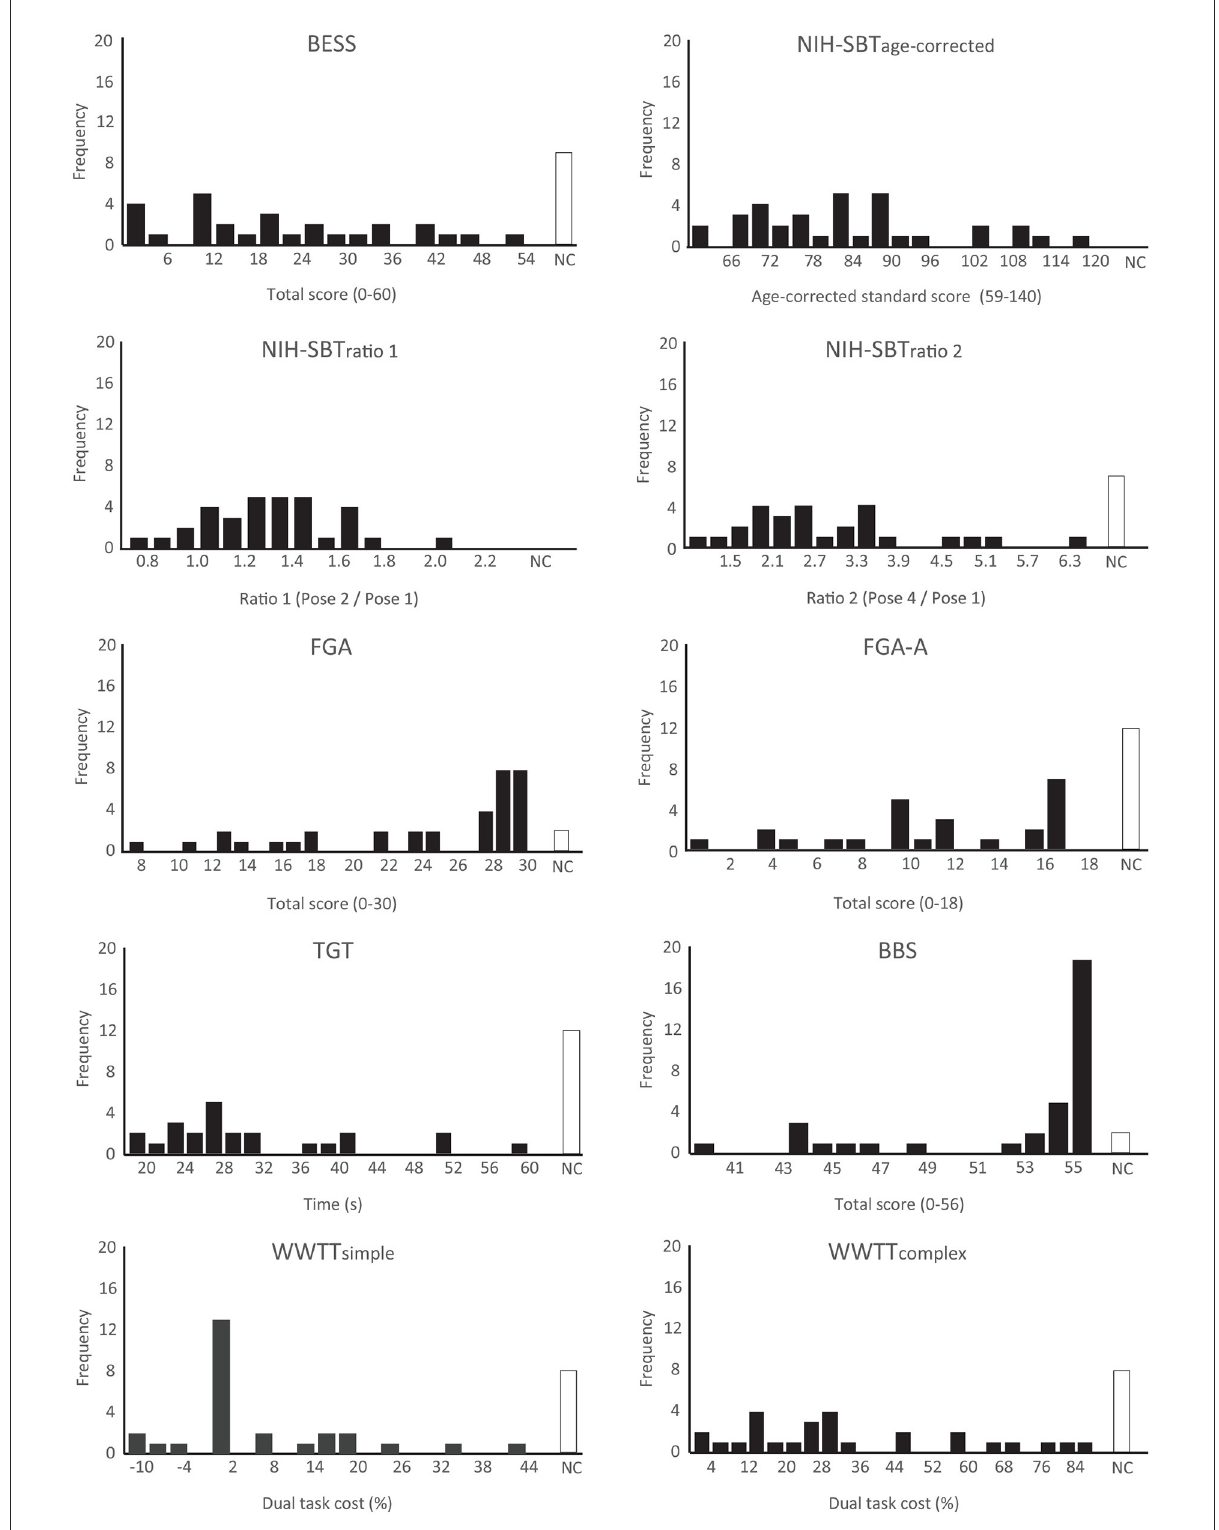
FIGURE1 Histograms presenting score distributions of all balance measures included in the SiMPly Rehab testing battery. One extreme outlier ( > 3 * IQR from Q1 or Q3) was excluded on the NIH-SBT ratio1 and TGT. Two extreme outliers were excluded on the WWTT-simple and WWTT-complex. NC: Assessment not completed; Q1: first quartile; Q3: third